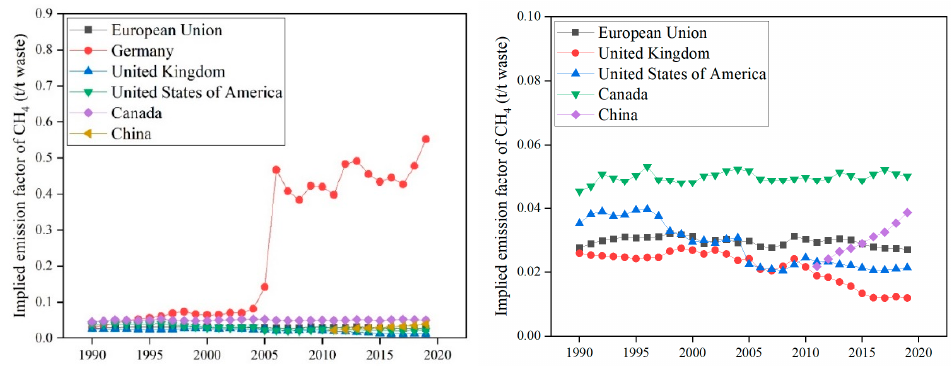
Figure 5. Implied emission factor of CH 4 from landfill